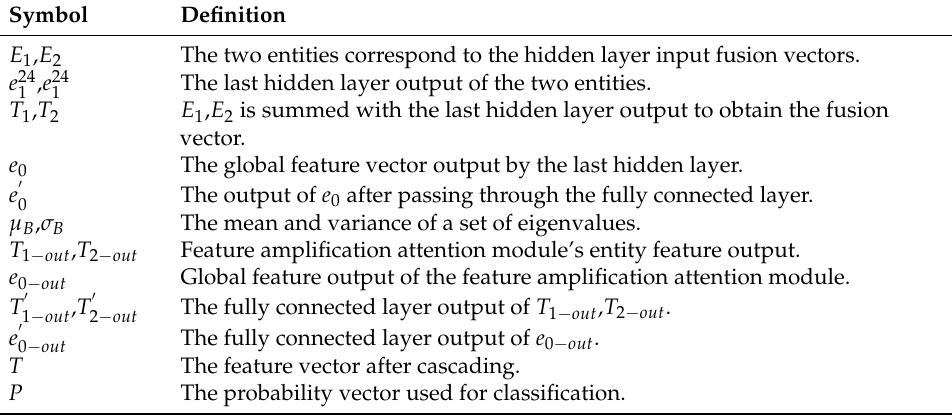
Figure 1. The general architecture of the FA-RCNet model. Table 2. Symbols and